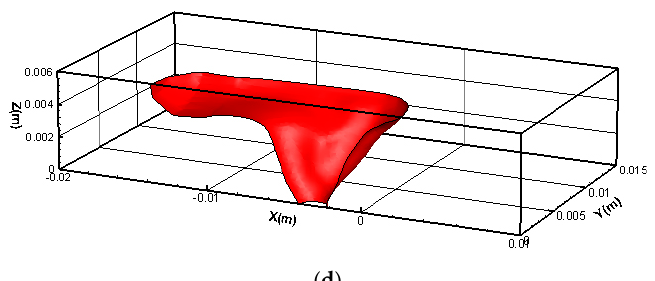
Figure 6. Dynamic evolution of weld pool in the mobile PAW process. ( a ) t = 0.4 s; ( b ) t = 0.9 s; ( c ) t = 2.1 s; ( d ) t = 3.2 s.